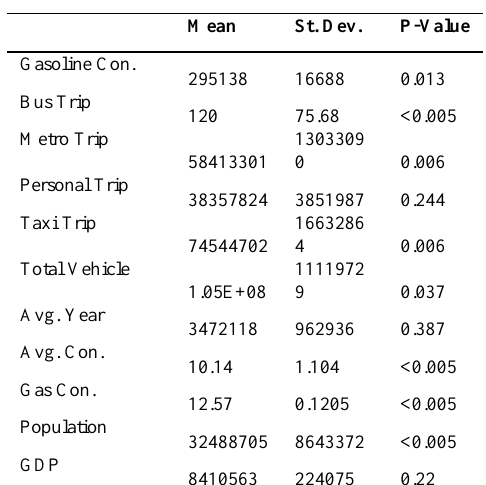
Table 10. Normality test for data after